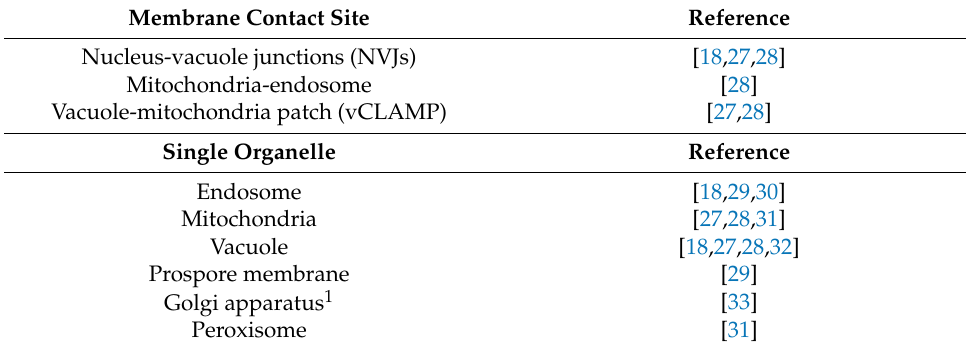
Table 2. Localization of yeast Vps13